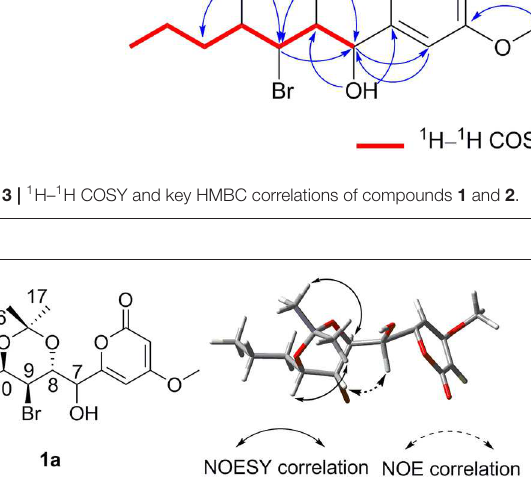
for 1a-1 and 1a-2 were performed with DP4 + method. As a result, 1a-2 was identified as the most likely candidate with 100% DP4 + (carbon data) probability ( Supporting Informations 2 , 3 ), which was consistent with the aforementioned